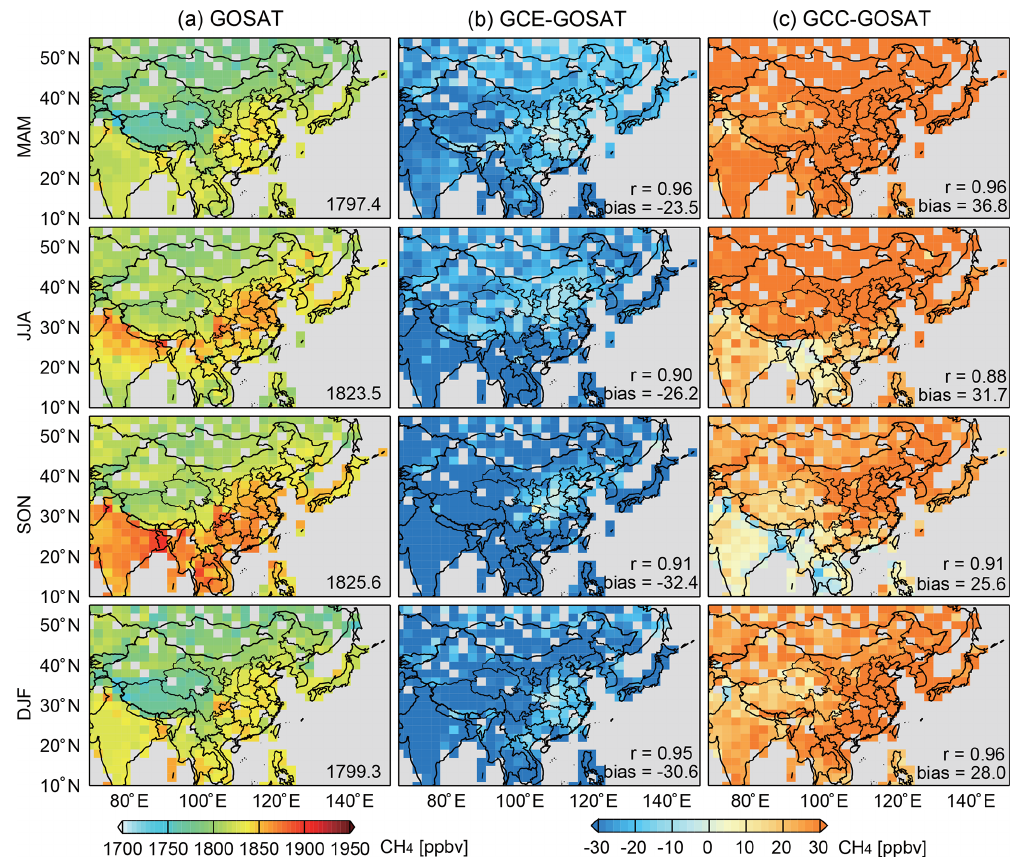
Figure 7. The 2010–2017 seasonal mean GOSAT-observed and model-simulated atmospheric CH 4 mixing ratios over Asia. Both observa- tions and the GEOS-Chem model simulations are re-grided to the 2 ◦ × 2 . 5 ◦ model resolution. The model results are then applied with satellite averaging kernels. The middle and right panels show, respectively, GCE (with EDGAR anthropogenic emissions and interannually varying OH; column b ) minus GOSAT (column a ) and GCC (with CEDS and interannually varying OH; column c ) minus GOSAT differences. The observed mean atmospheric CH 4 mixing ratio, GOSAT vs. model correlation coefficients ( r ), and mean model biases over China are